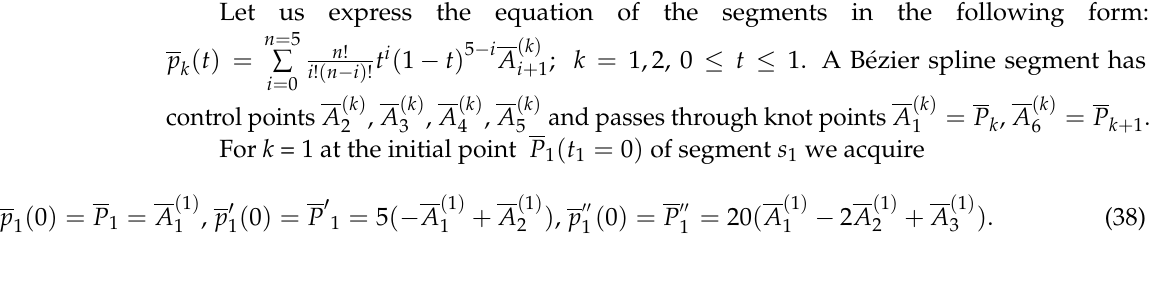
Figure 16. Knot and control points of two connected segments of a fifth-degree Bézier spline curve.